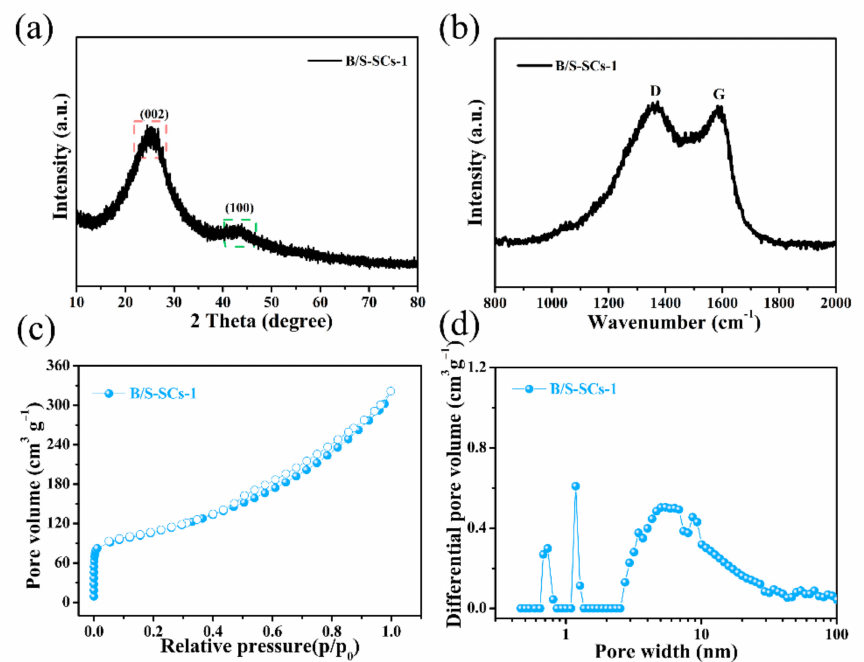
Figure 3. ( a ) XRD pattern; ( b ) Raman spectra; ( c ) nitrogen adsorption/desorption isotherm; ( d ) pore size distribution of the obtained B/S-SC S -1